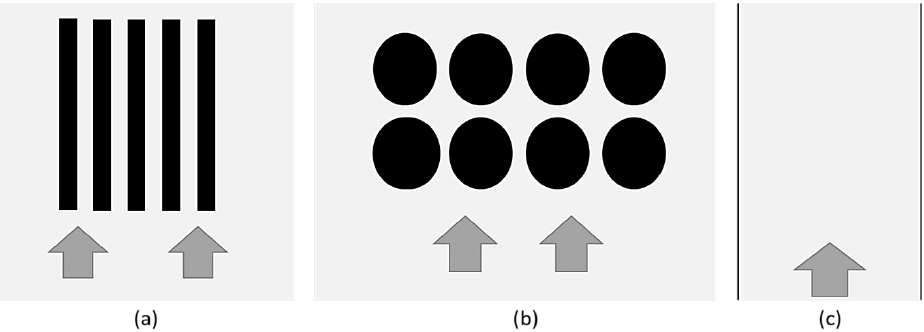
Figure 3. Types of two-phase flow. ( a ) Axial flow, ( b ) cross flow, ( c ) internal